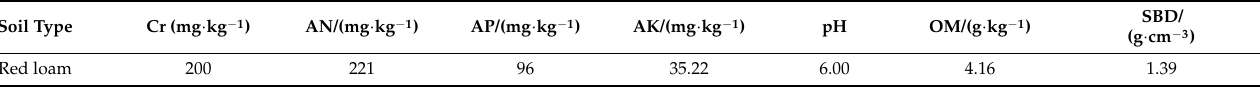
Table 1. Basic physical and chemical properties of tested